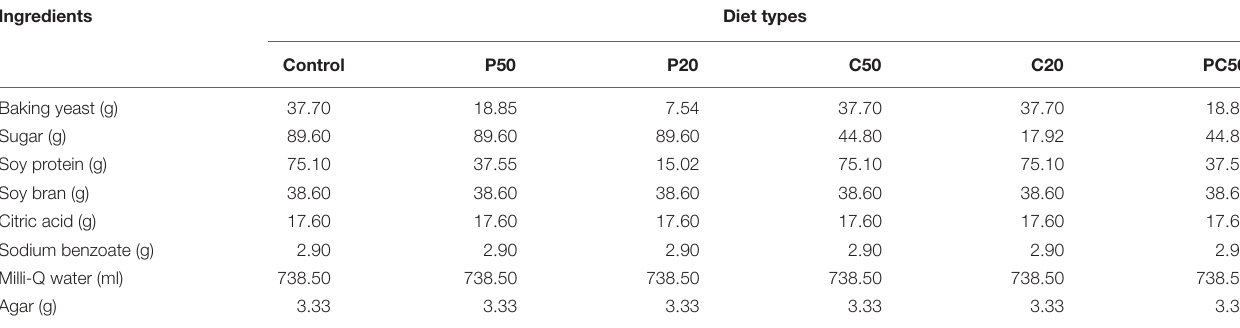
TABLE 1 | Components used to prepare the artificial diet (1 L) for the rearing of B. dorsalis